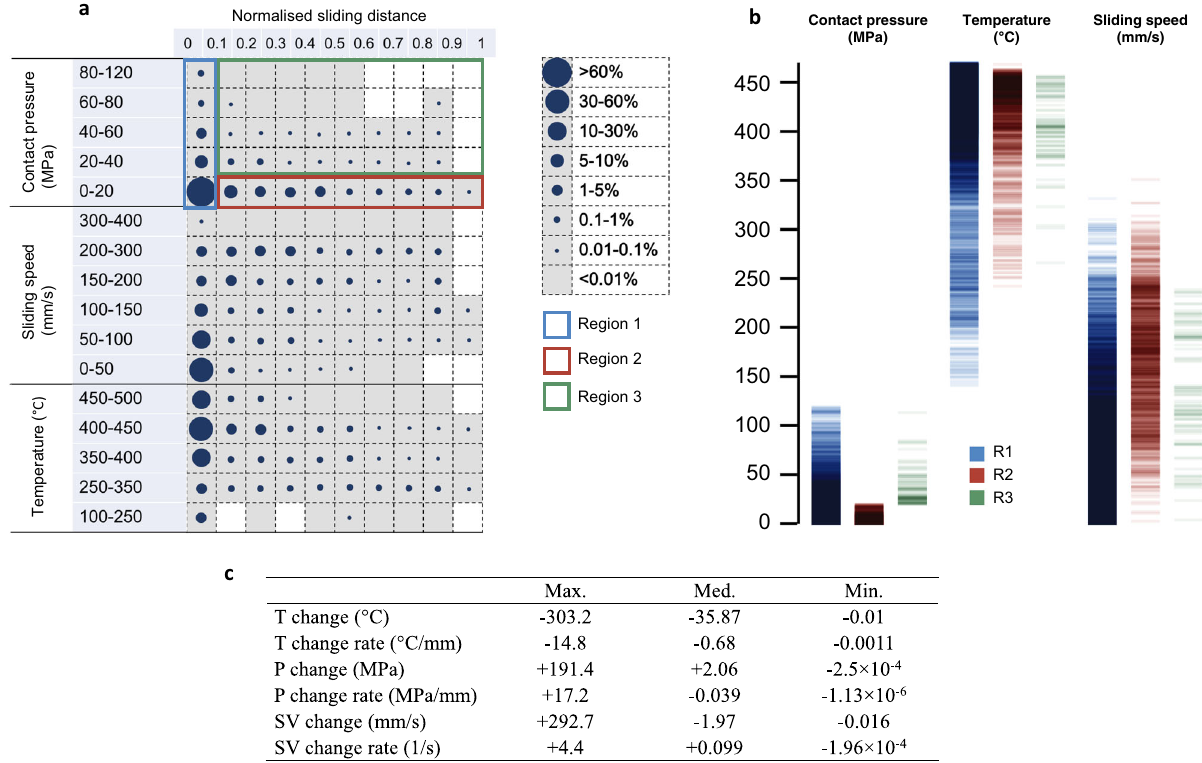
Fig. 1 | Digital characteristics (DCs)ofthe hotstamping process. a Distribution of probability of the tooling elements falling into a speci fi c range de fi ned by the contact condition and normalised sliding distance. Circle sizes indicate the mag- nitude of the probability. Rectangular frames show the division of different key regions. b Distribution of contact condition values in different key regions, i.e.